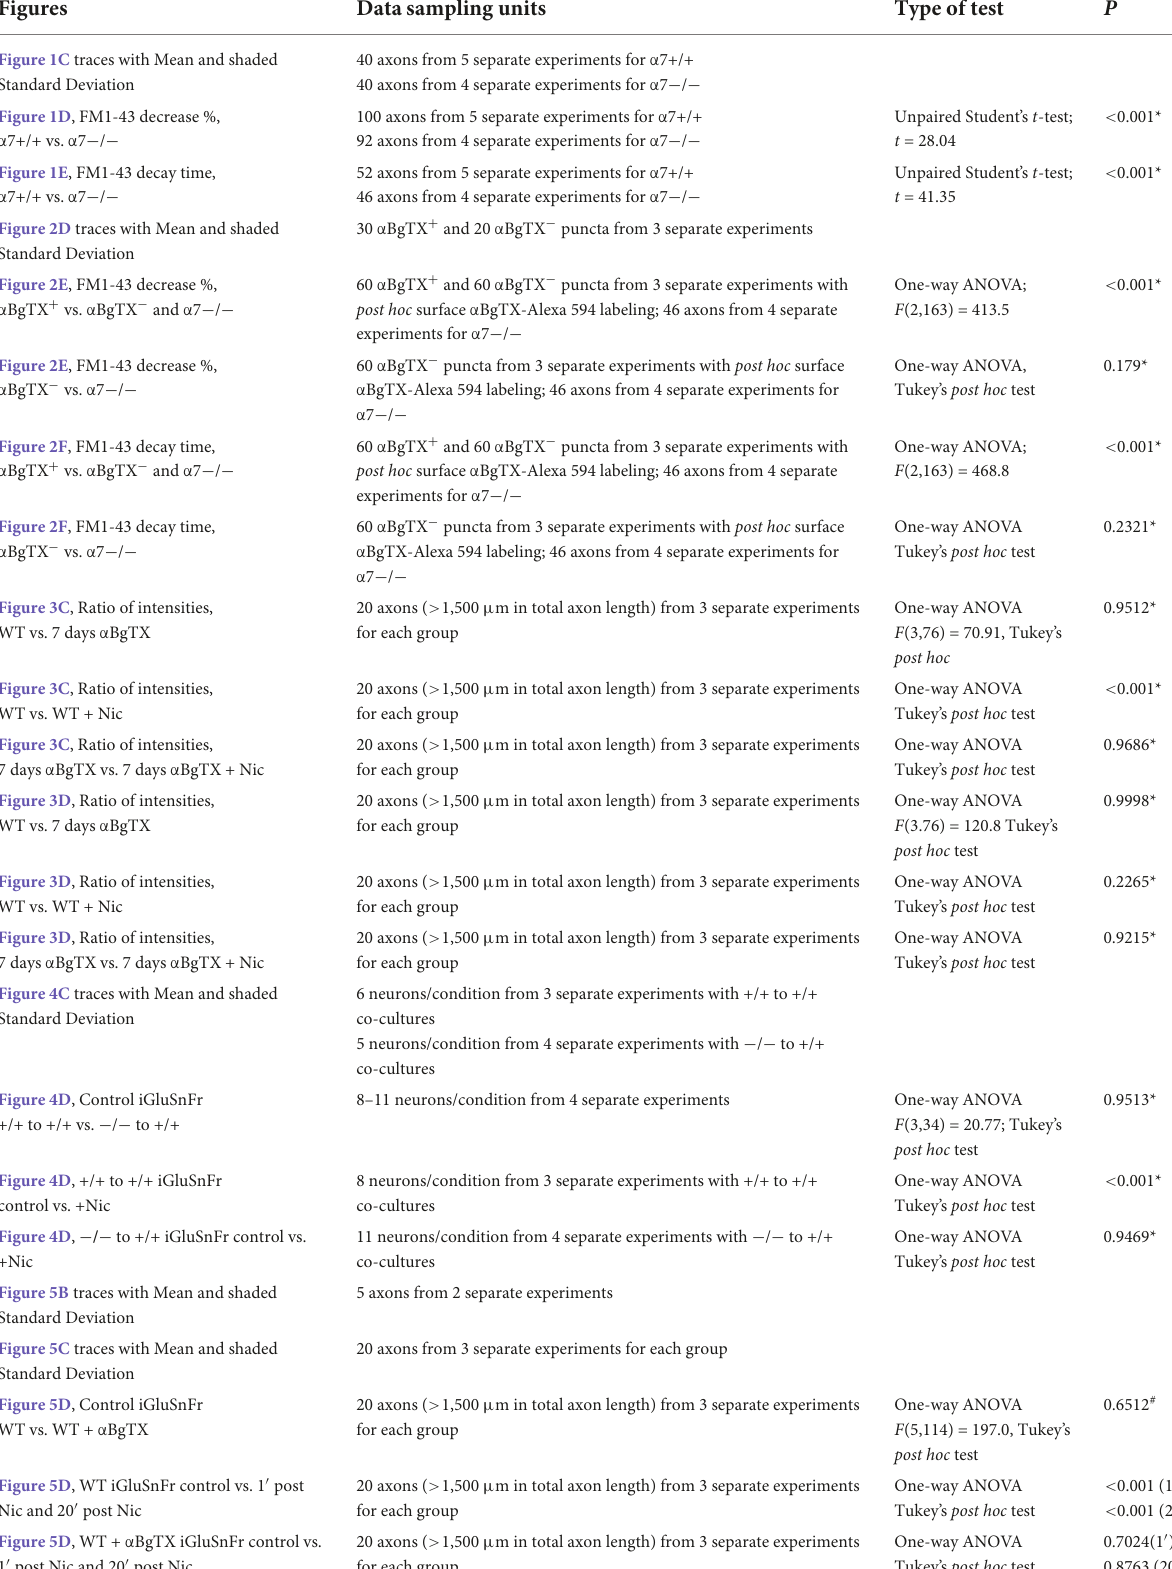
TABLE 1 Statistical analyses used in this study.